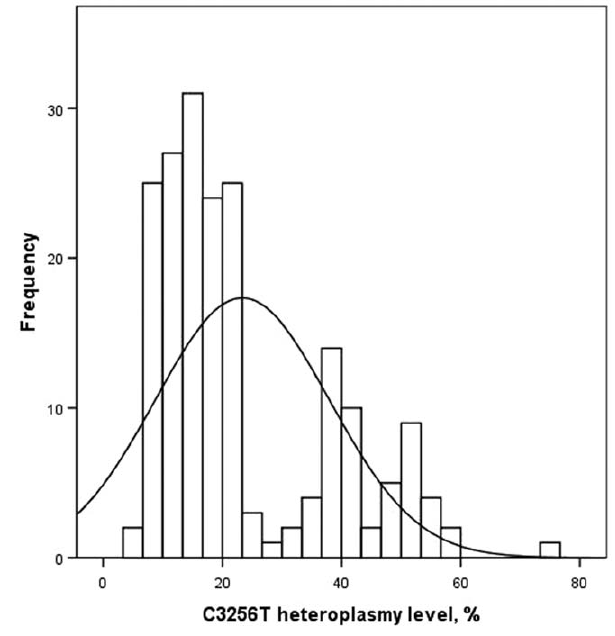
Figure 3. Histogram showing the distribution of the level of C3256T heteroplasmy of mitochondrial DNA from white blood cells. Theoretical normal distribution is shown by solid curve. doi:10.1371/journal.pone.0046573.g003 PLOS ONE |